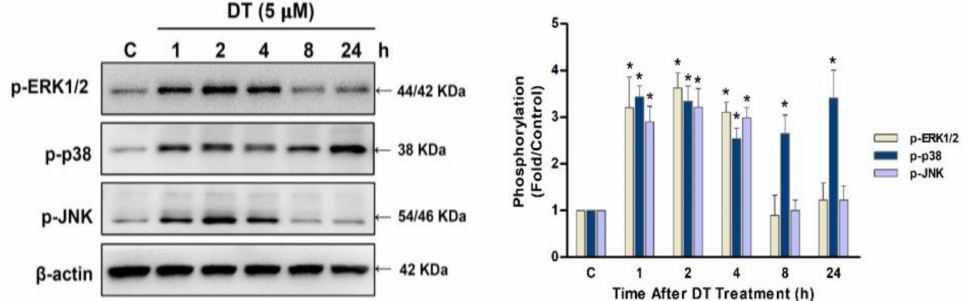
Figure 6. DT induced the phosphorylation of ERK1/2, p38, and JNK kinases in Detroit 562 cells. Cells were treated with 5- µ M DT for 1, 2, 4, 8, and 24 h, and antibodies against phosphorylated (p)-ERK1/2, p-p38, and p-JNK were used to analyze the phosphorylation status of these kinases through Western blotting. The fold changes were calculated from three independent experiments and are presented as means and standard errors of the mean. * indicates a statistically significant difference compared with untreated control